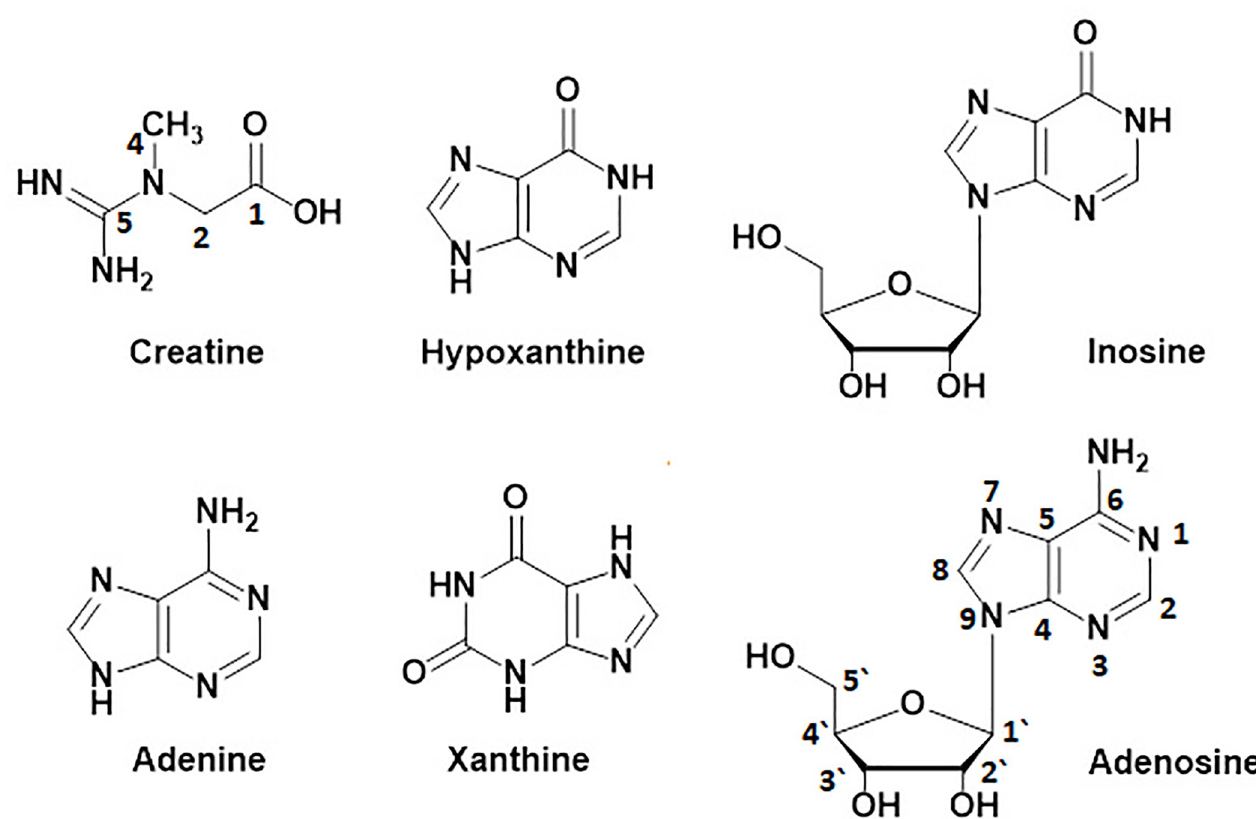
Fig 2. Chemical structures of other nitrogenous compounds isolated from the deterrent water-soluble fraction of the sea lamprey skin extract: creatine, hypoxanthine, inosine, adenine, xanthine, and adenosine.